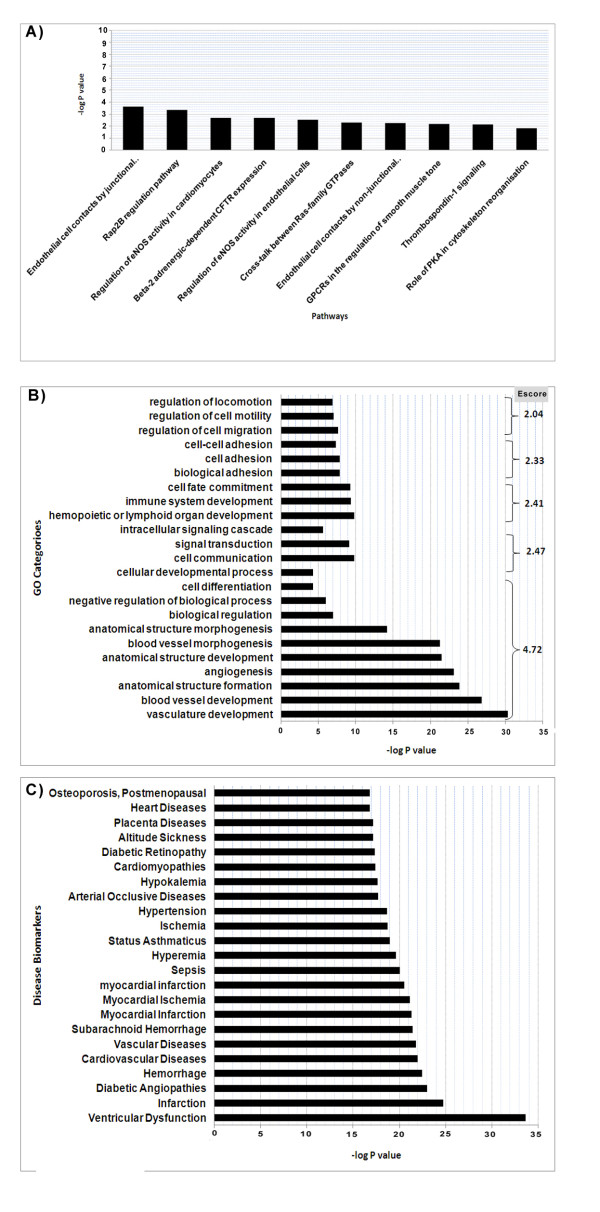
Enrichment analysis of EC-restricted genes. A) Top enriched Canonical Pathways B) Top enriched GO Processes. C) Top enriched disease set. The analysis for pathways and disease set enrichment was performed using the MetaCore tool of the GeneGo package. The GO categories enrichment analysis was performed using the DAVID tool. The Bar graphs depict the enriched pathway or Go process categories and -log of the P value. The P value depicts the significance of enrichment, the smaller is the P value the more significant is the enrichment. The pathways and disease sets with FDR adjusted P value < 0.05 are considered significant. The panel for gene ontology enrichment depicts the enrichments for each GO category (-log P value) as well as the Escore for a cluster of related GO categories.